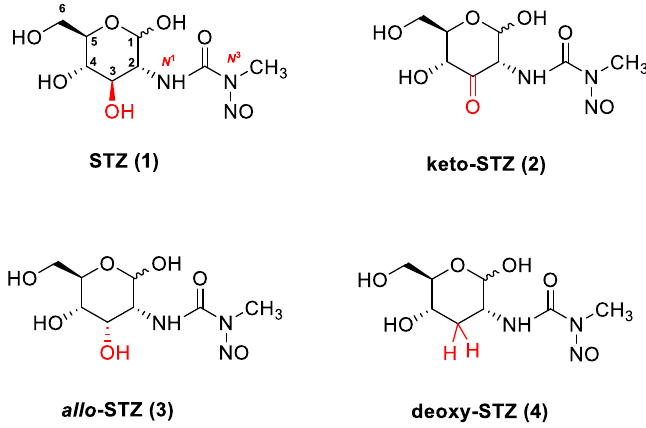
Figure 1. Structures of Streptozotocin (STZ) ( 1 ), and the STZ-derivatives ( 2 – 4 ) synthesized and evaluated in this project.